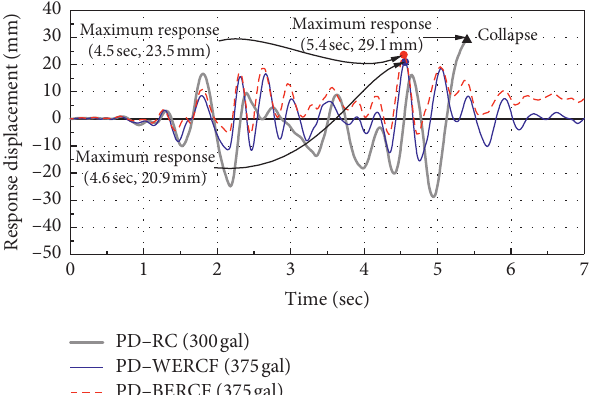
Figure 17: Response displacement-time history relationships of the control specimen and ESRCF-strengthened specimens during pseudodynamic testing at 375